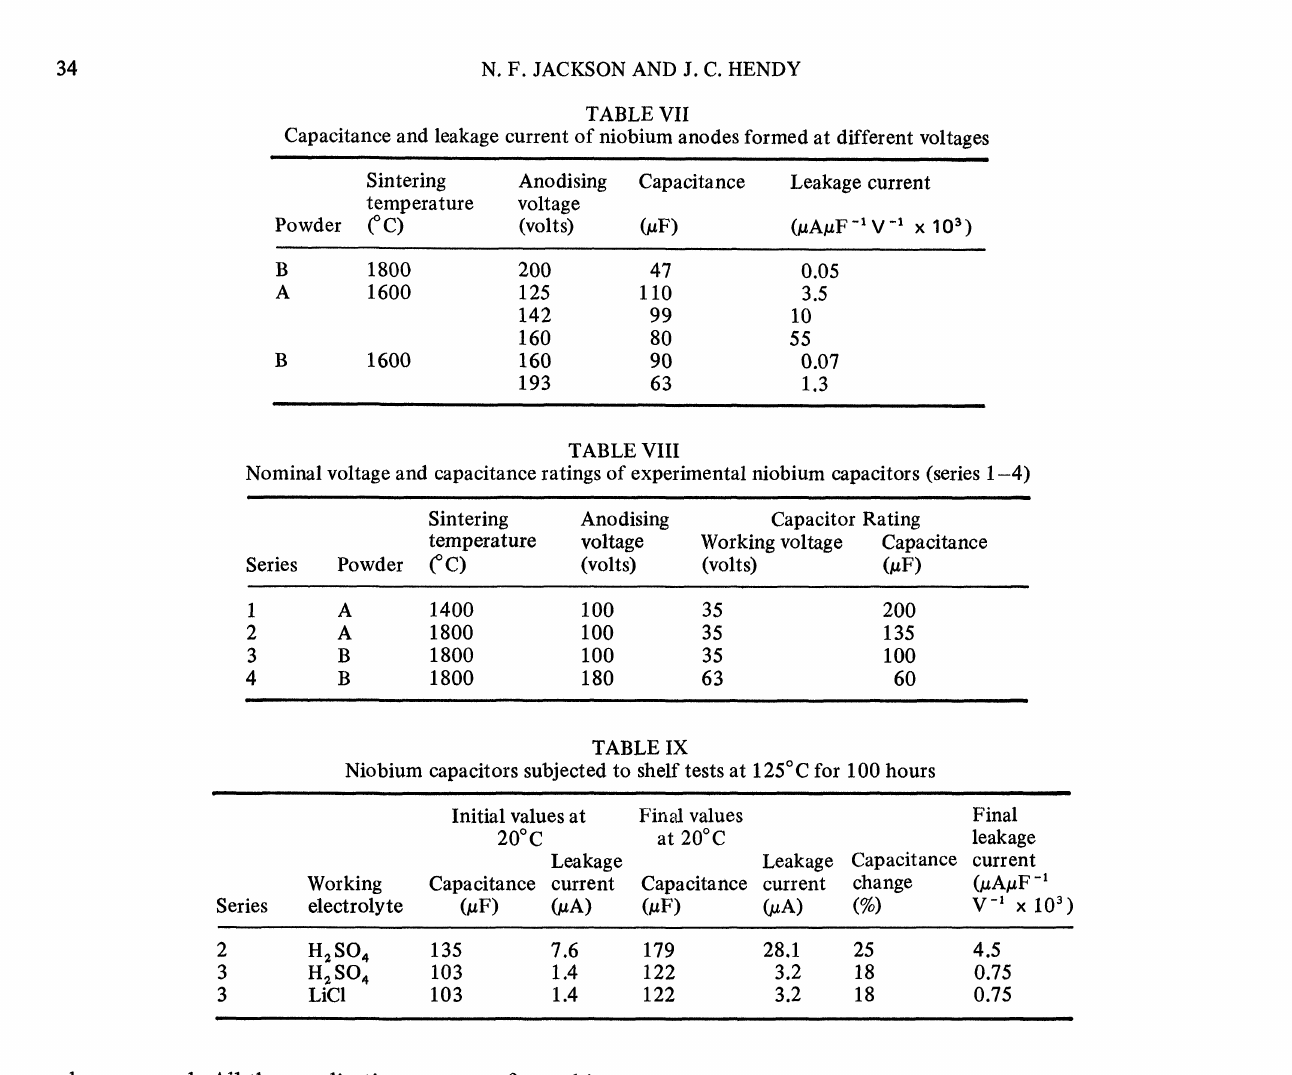
TABLE VII Capacitance and leakage current of niobium anodes formed at different voltages